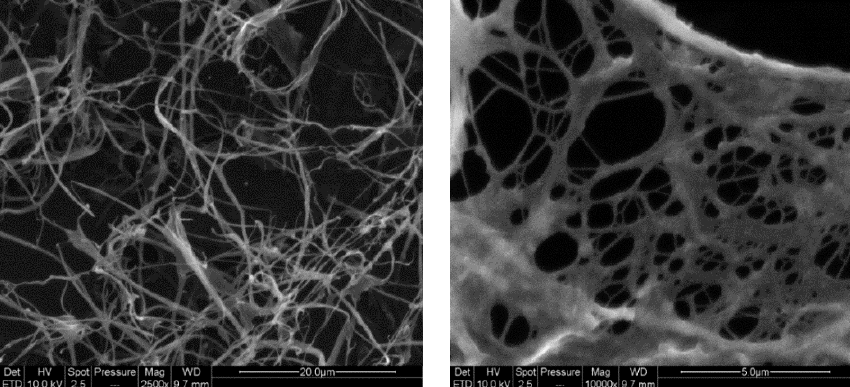
Figure 4. SEM images of a film of carboxymethylated nanocellulose, highlighting the fibrous three-dimensional structure of the material.